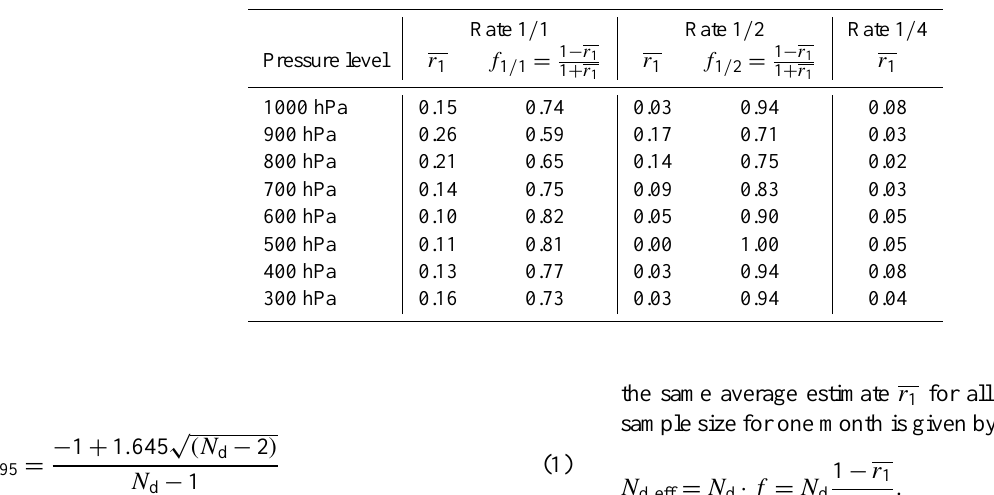
Table 1. First order autoregressive coefficients ( r 1 ) and scaling factors for effective sample size derived from the 61 full months at rate 1 / 1 (sample every day), rate 1 / 2 (sample every other day) and rate 1 / 4 (sample every fourth